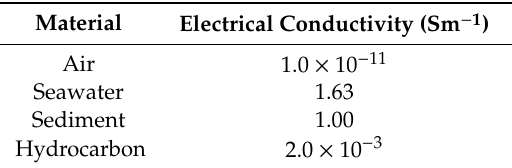
Table 1. Electrical conductivity of every layer considered in the SBL models. Conductivity is the reciprocal of resistivity. The electrical conductivity of the hydrocarbon layer is lower than its surroundings, which are seawater and sediment. It means that the hydrocarbon layer is parameterized with reliable electrical resistivity.